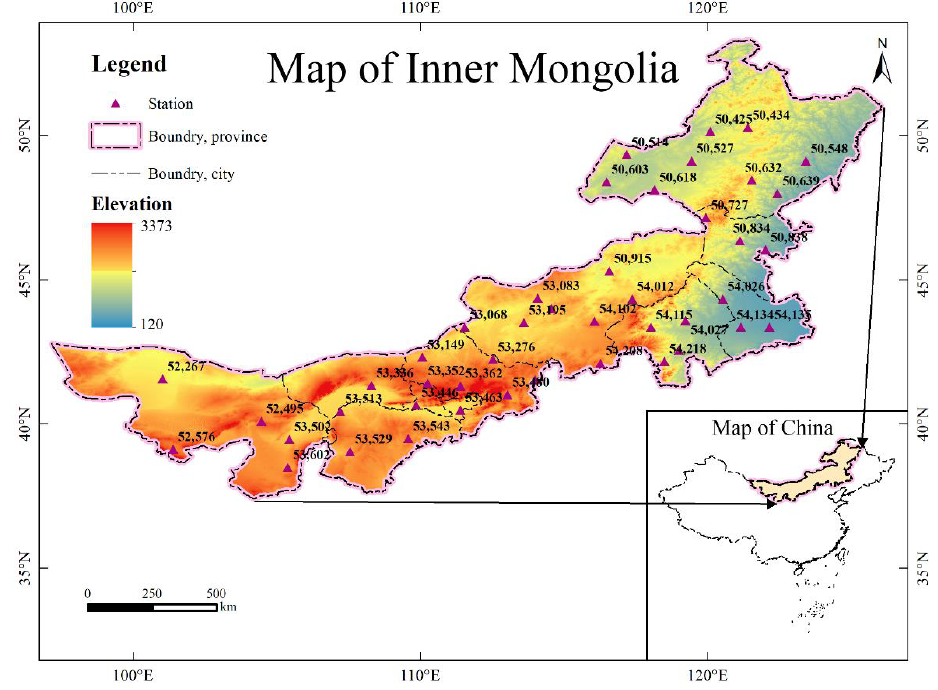
Figure 1. Study area and observed meterological stations. The average elevation of Inner Mongolia is about 1000 m. The highest elevation